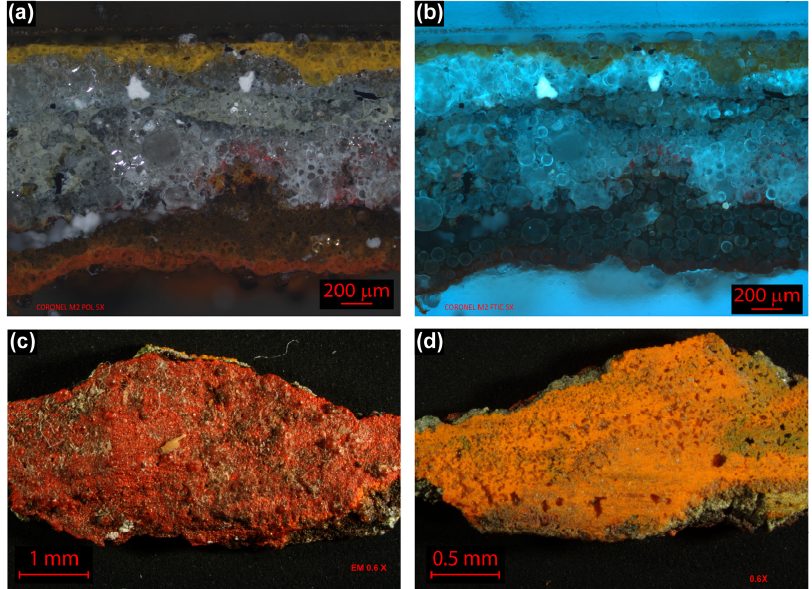
Figure 2. Cross section micrograph of the mural Paisaje Abstracto sample (area studied approxi- mately 2100 × 1400 microns, magnification: 5×). ( a ) Polarized light; ( b ) UV filter, 460 to 490 nm (FITC); ( c ) sample without preparation, front surface area (approximately 3 × 6 mm); ( d ) back of the sample. Images ( a , b ), the cross section micrographs present the paint layers in reverse order (those closest to the panel are at the top).